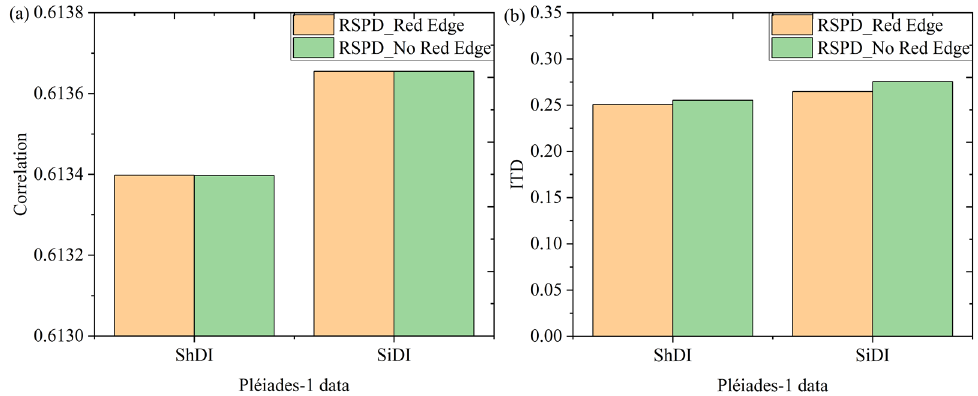
Figure 14. Pl é iades—ShDI/SiDI was used to test the effect of red-edge bands on RSPD (( a ) is the correlation result and Figure 14. Pléiades—ShDI/SiDI was used to test the effect of red ‐ edge bands on RSPD (( a ) is the correlation result and ( b ) ( b ) is the ITD is the ITD result).